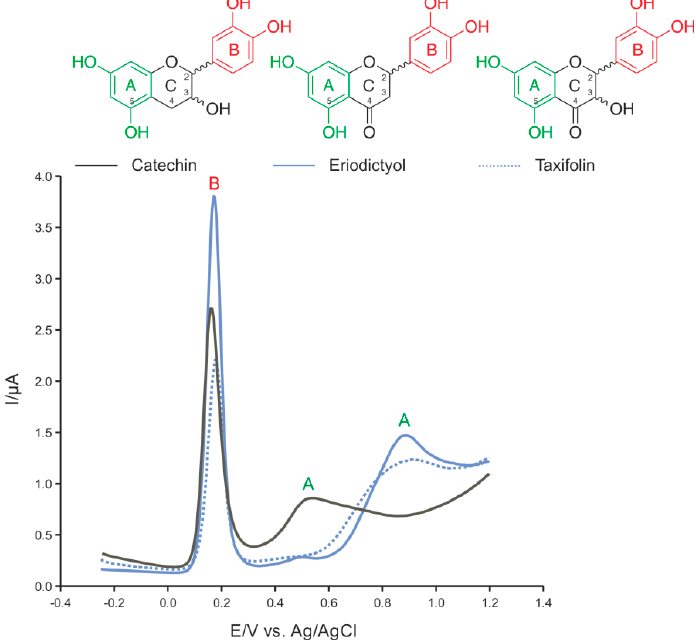
Figure 2. Differential pulse voltammograms of the tested flavans: catechin, eriodictyol, and taxifolin. Table 1. Electrochemical variables for flavan ring A and ring B hydroxyl groups extracted from differential pulse voltammogram data (mean ± SD of three measurements)